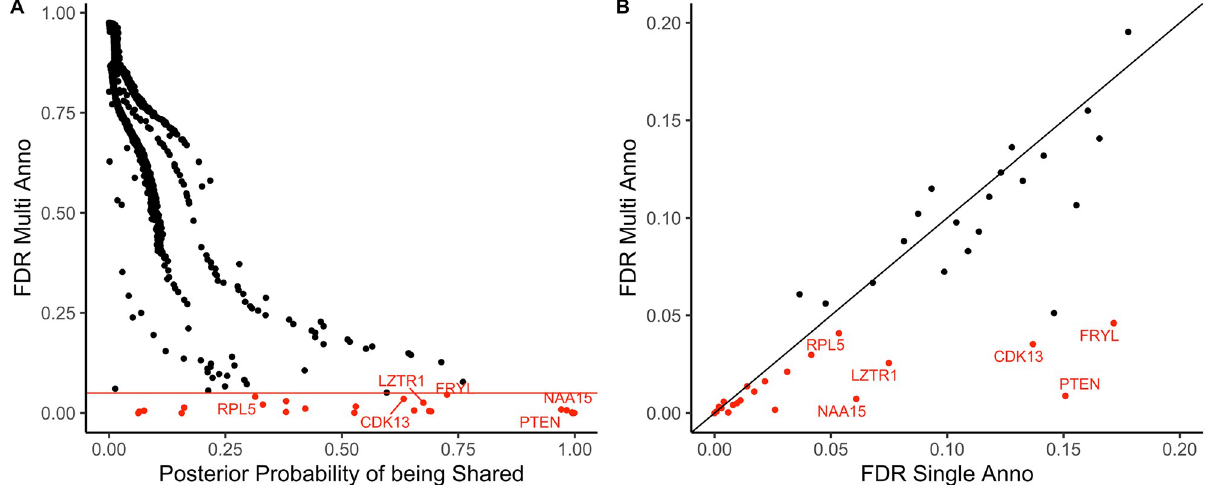
Fig 6. Multi-trait analyses prioritized additional genes with high posterior probability of being shared risk genes for CHD. The 23 genes identified by the multi-trait model with annotations are marked in red on the plot and the additional 6 genes that were identified by the multi-trait models are annotated with gene symbols. (A) shows that the 6 additional genes identified by the multi-trait models had high posterior probability of being shared. The x-axis represents the posterior probability of being shared calculated from the multi-trait model with annotations. The y-axis represents the FDR of genes calculated from the multi-trait model with annotations. (B) shows that the top genes in the multi-trait model with annotations also had low FDR ( < 0.2) in the single-trait model with annotations. The x-axis represents the FDR of genes calculated from the single-trait model with annotations. The y-axis represents the FDR of genes calculated from the multi-trait model with